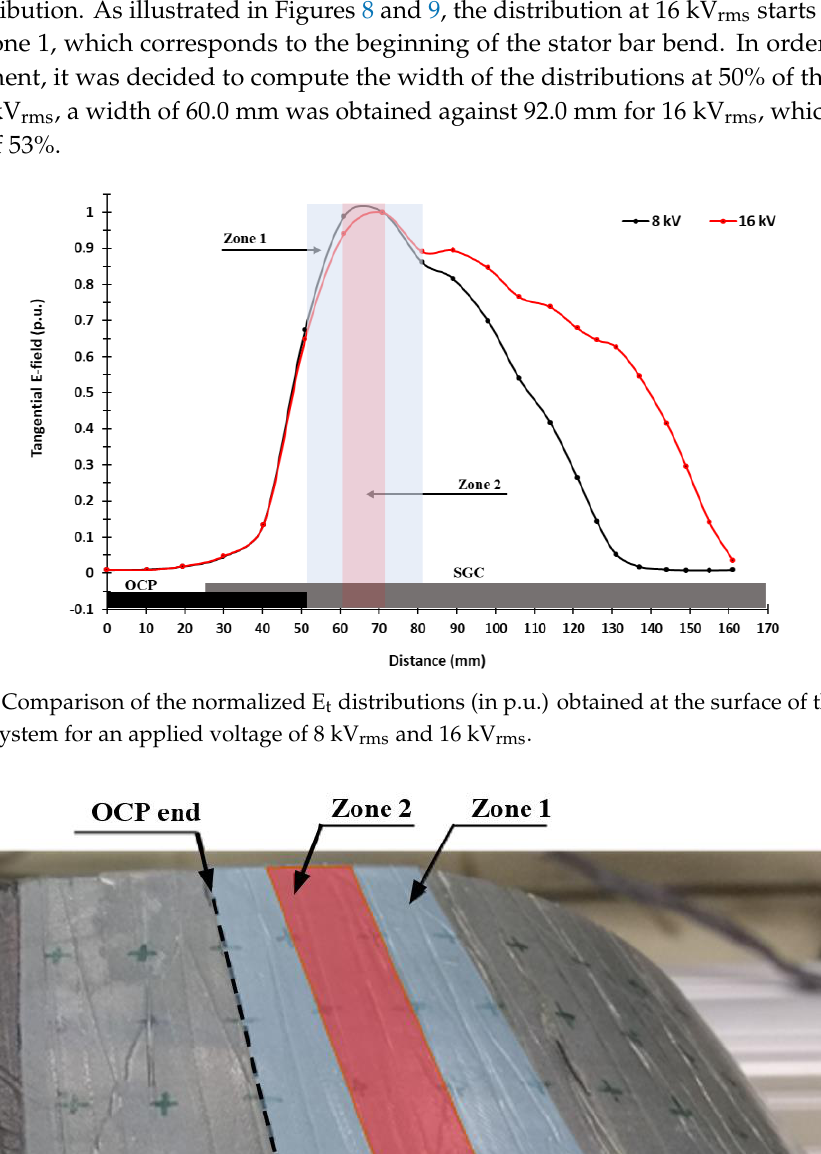
Figure 7. Distributions of the E t obtained at the surface of the stress grading system for an applied voltage of 8 kV rms and 16 kV rms .